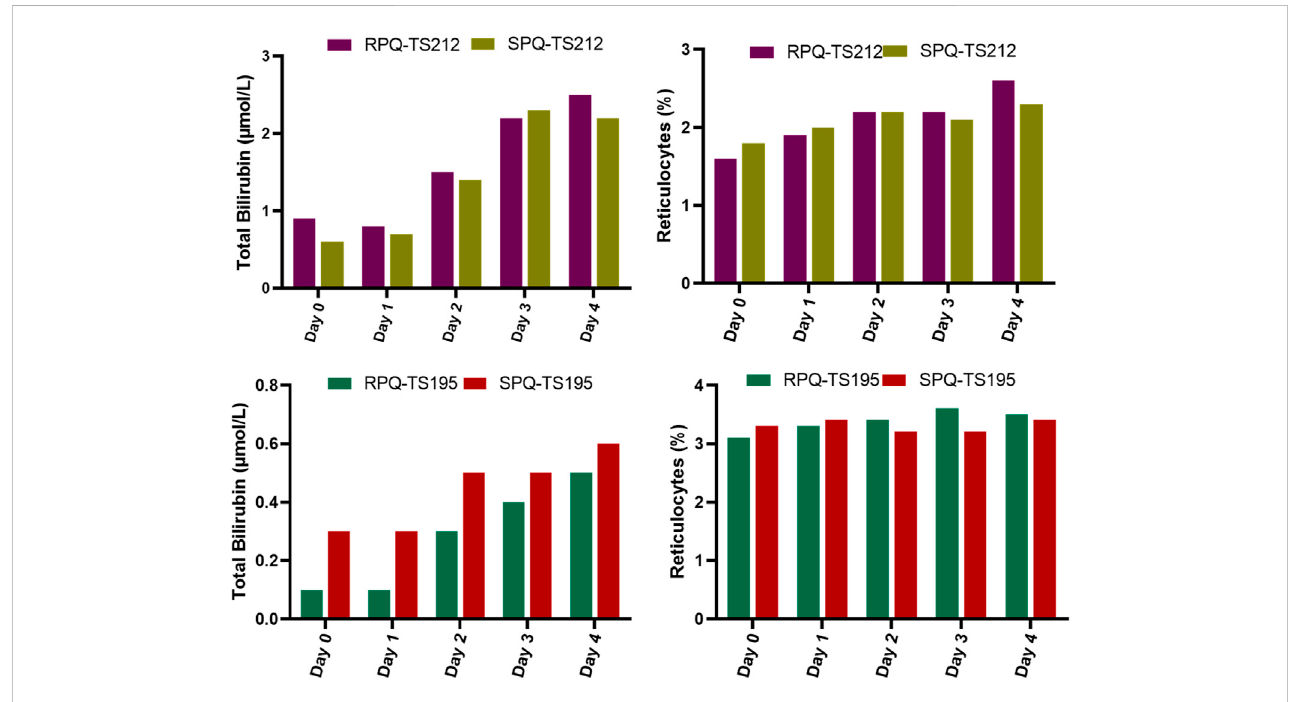
poor CYP 2D6 metabolizer phenotypes show a reduced